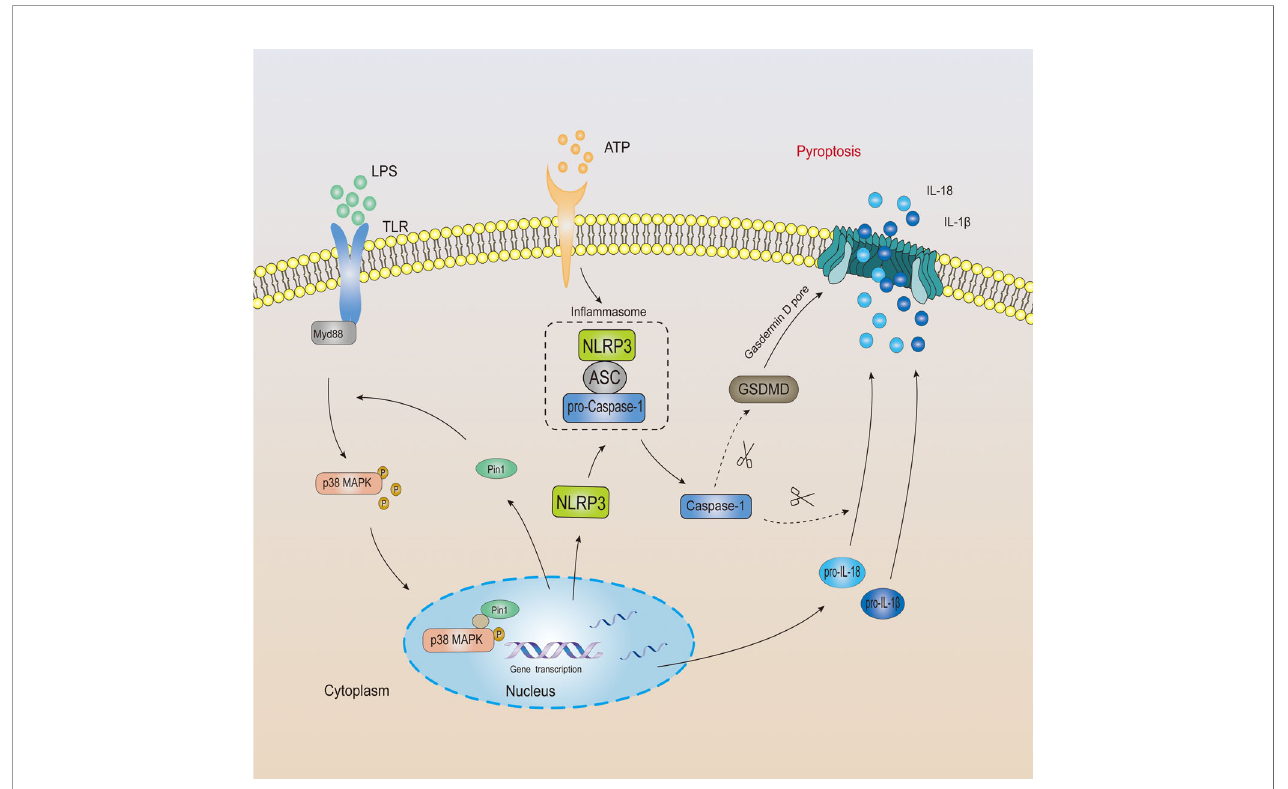
FIGURE 7 | The mechanistic model of Pin1 mediated in fl ammasome activation and